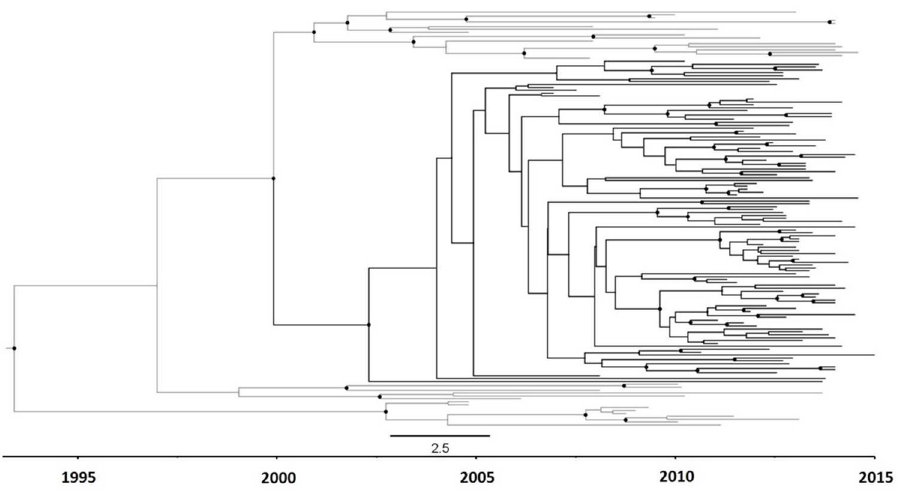
Fig 5. Dated phylogeny of the 143 sequences from the initial CV cluster. Branch lengths represent years. The CV cluster is highlightedin black. Dots on nodes represent posterior probabilities (cid:21) 0.90.